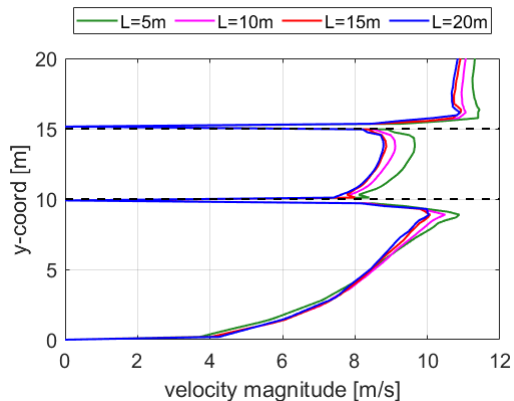
Figure 3. Velocity profiles along line 1 for different L values. The portion of the velocity profile between the black dashed lines impacts the platform.